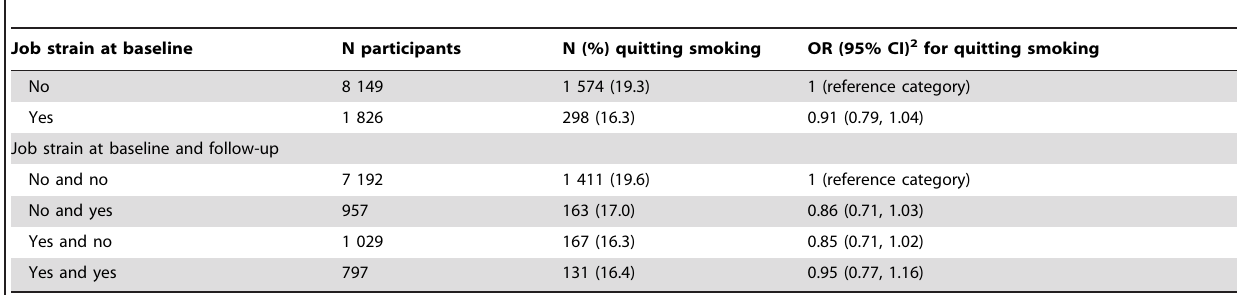
Table 4. Longitudinal associations between job strain at baseline and quitting smoking among baseline smokers (n=9 975) 1 .